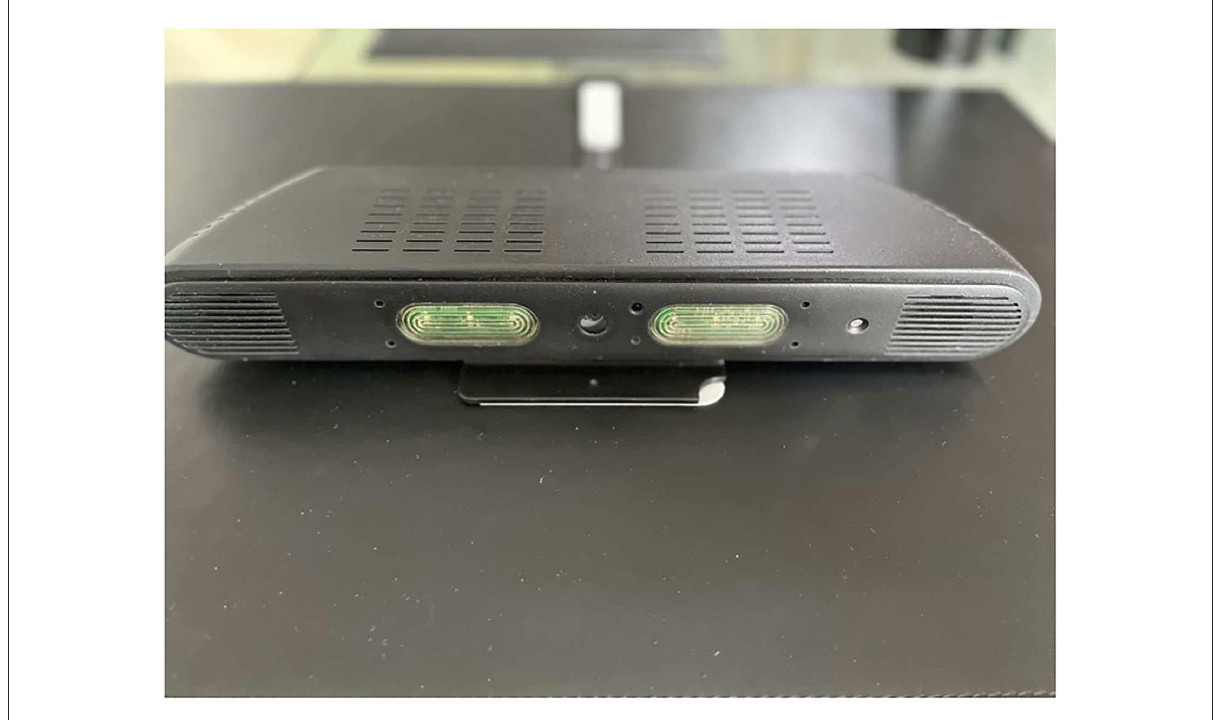
FIGURE5 Kraydel Konnect first prototype.